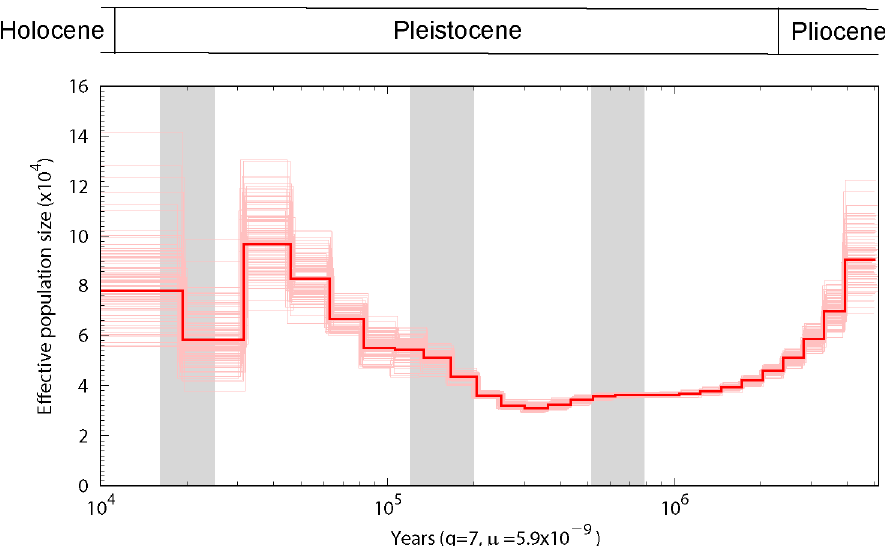
Figure 3. Inference of southern giant petrel population history based on pairwise sequential Markovian coalescent (PSMC) analysis. The red curve is the PSMC estimate for the original data, and the pink curves indicate the PSMC estimates for 100 bootstrapped sequences. The last glacial maximum (LGM), penultimate glaciation and the Naynayxungla glaciation are highlighted in gray vertical bars.